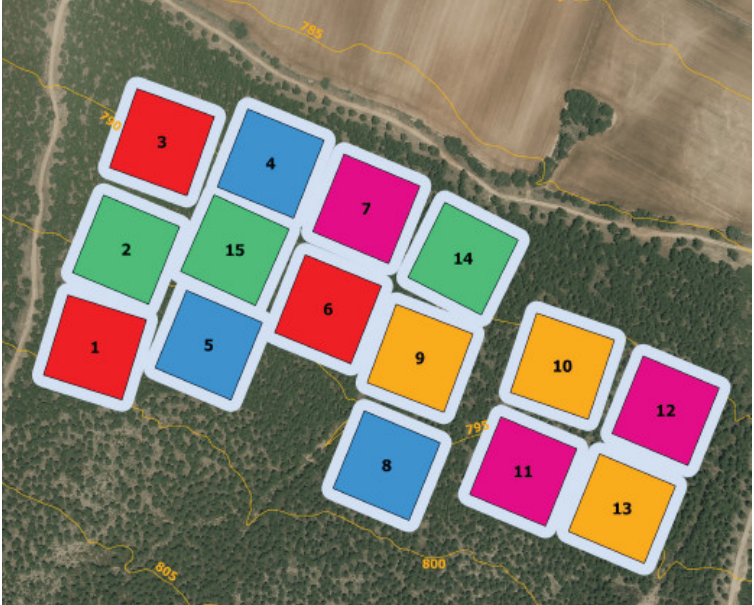
Figure 2. Type of treatment per plot. Light thinning (blue), strong thinning (red), transformation to uneven-aged (yellow), diameter-driven uneven-aged (pink), and control plots (green).